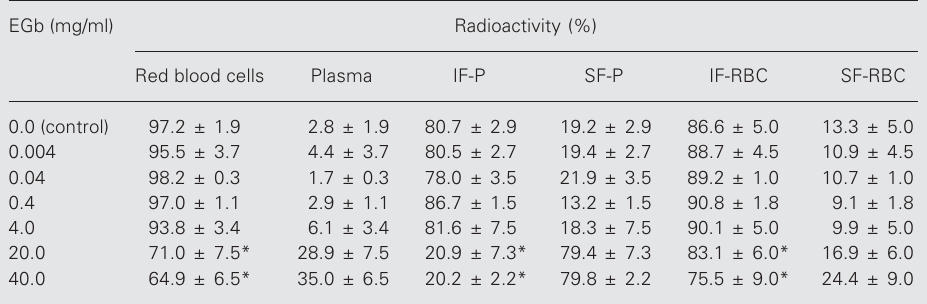
Heparinized blood was incubated with Ginkgo biloba crude extract (EGb). Stannous chloride, 1.2 µg/ml, was present in all samples. The radioactivity incorporated into each fraction is reported as percent recovered in IF- P plus SF-P, IF-RBC plus SF-RBC and RBC plus plasma. IF-P = insoluble plasma fraction; IF-RBC = insoluble red blood cell fraction; SF-P = soluble plasma fraction; SF-RBC = soluble red blood cell fraction. *P < 0.05 compared to control (ANOVA, N = 6 per